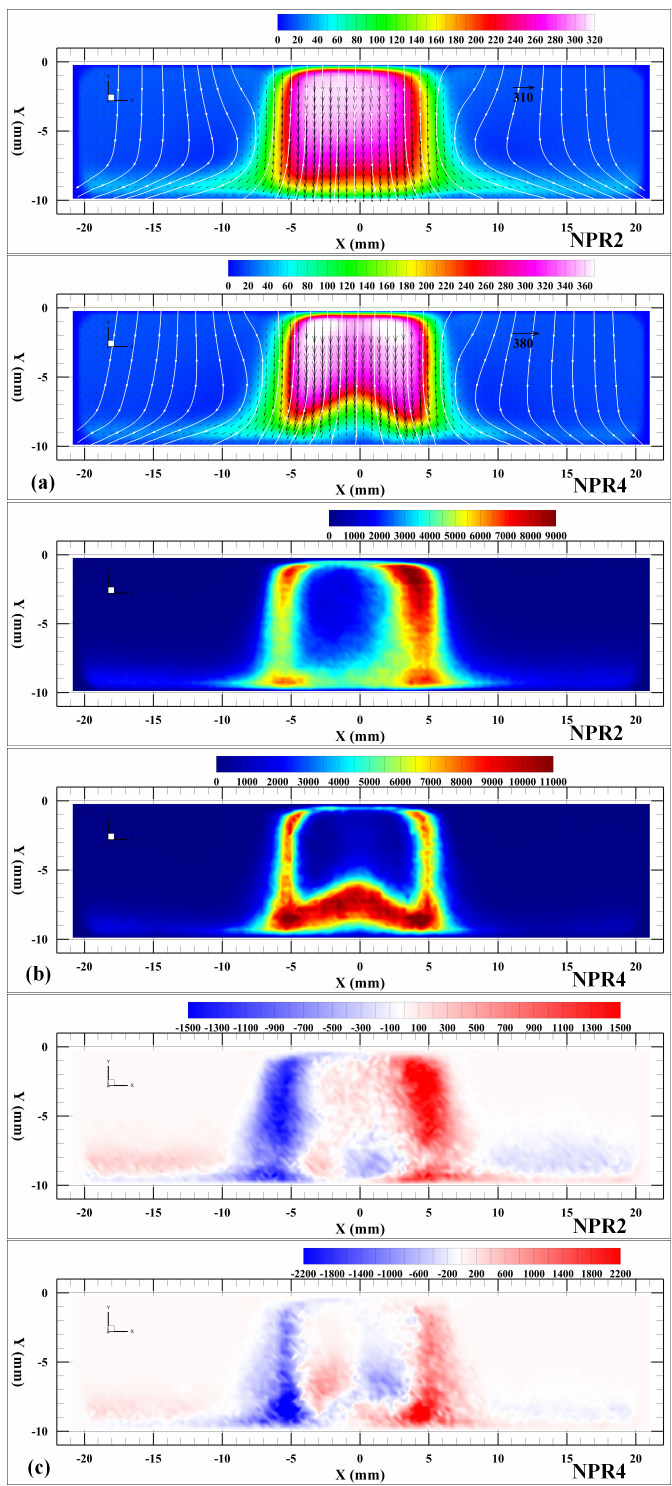
Figure 6. PIV results obtained from experimental measurements of impinging jets with the nozzle-to-plate e = 10 mm ( e / D j = 0.82) and at NPR 2 = 2.2 and NPR 4 = 2.77. ( a ) Mean in-plane velocity fields, color contour of velocity magnitude (m/s) and velocity streamlines, color contours of ( b ) turbulent kinetic energy k (m 2 /s 2 ), and ( c ) Reynolds stress (cid:104) u (cid:48) v (cid:48) (cid:105) (m 2 /s 2 ). Vectors were de-sampled for better